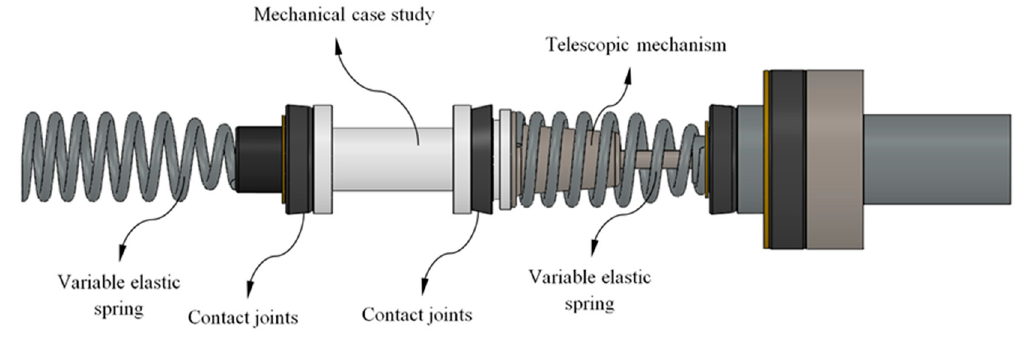
Figure 1. Automotive assembly.